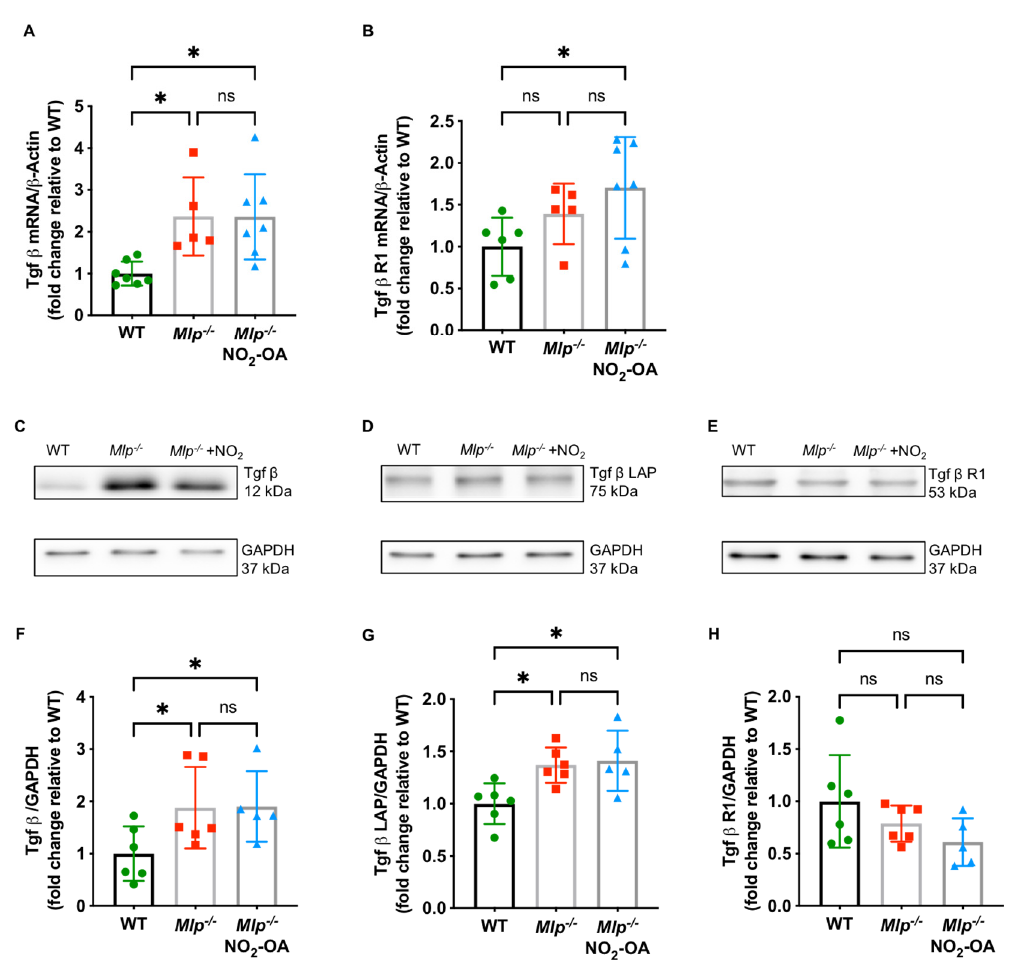
Figure 3. TGF β signaling Mlp − / − hearts. ( A ) qPCR reveals increased mRNA expression levels of Tgf β in LV of Mlp − / − mice, whereas ( B ) expression of Tgf β R1 is unaffected. Representative immunoblot and quantification demonstrate increased protein expression levels of TGF β ( C , F ) and TGF β latency-associated protein (LAP) ( D , G ) in Mlp − / − mice, whereas protein expression levels of TGF β receptor 1 (R1) ( E , H ) is not influenced by the DCM phenotype. Data are expressed as mean ± SD, * p < 0.05, one-way ANOVA with Tukey multiple comparison test, n = 5–7 as